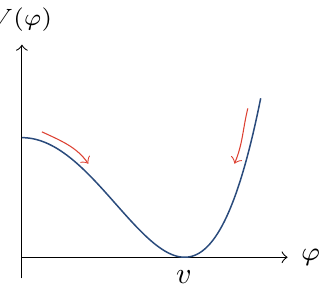
Figure 1 . A schematic view of the potential V ( ϕ ) . One can imagine two inflationary scenarios depending on ϕ < v or ϕ > v